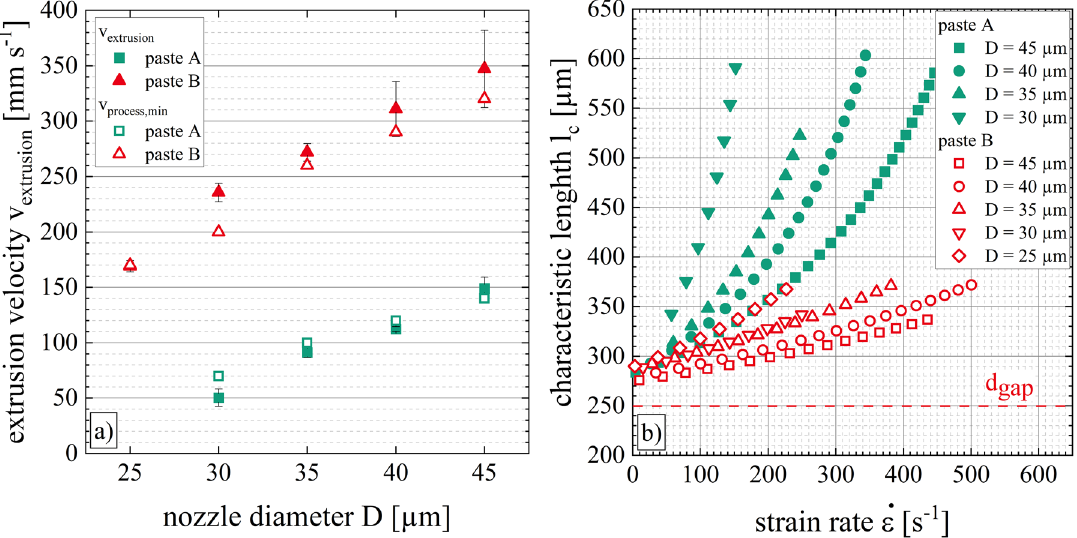
Figure 9. ( a ) Extrusion velocities v extrusion for various nozzle diameters and ( b ) its characteristic length l c over strain rate for low-temperature curing Ag pastes A and B. The extrusion of paste threads is observed by a high-speed imaging camera to determine the extrusion velocity v extrusion for each paste depending on the nozzle diameter of 45 µm ≥ D ≥ 25 µm. Besides, the minimal process velocities v process,min of Fig. 6 are shown to visualize our assumption v process,min = v extrusion . The characteristic length l c is calculated based on the equation in 13